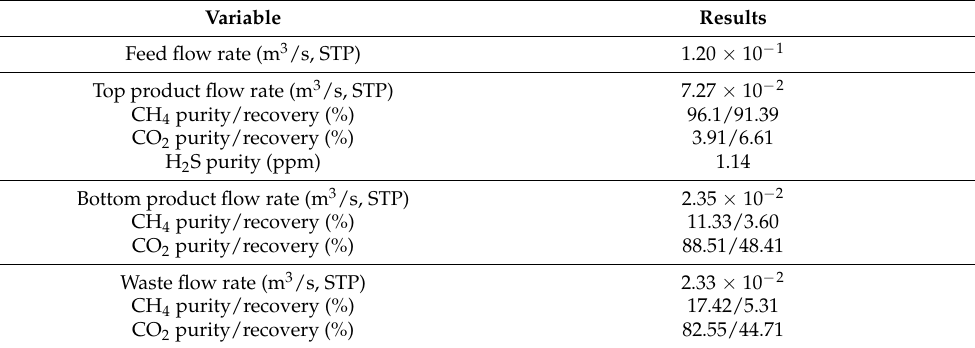
Table 20. Simulation results of the full scale PSA